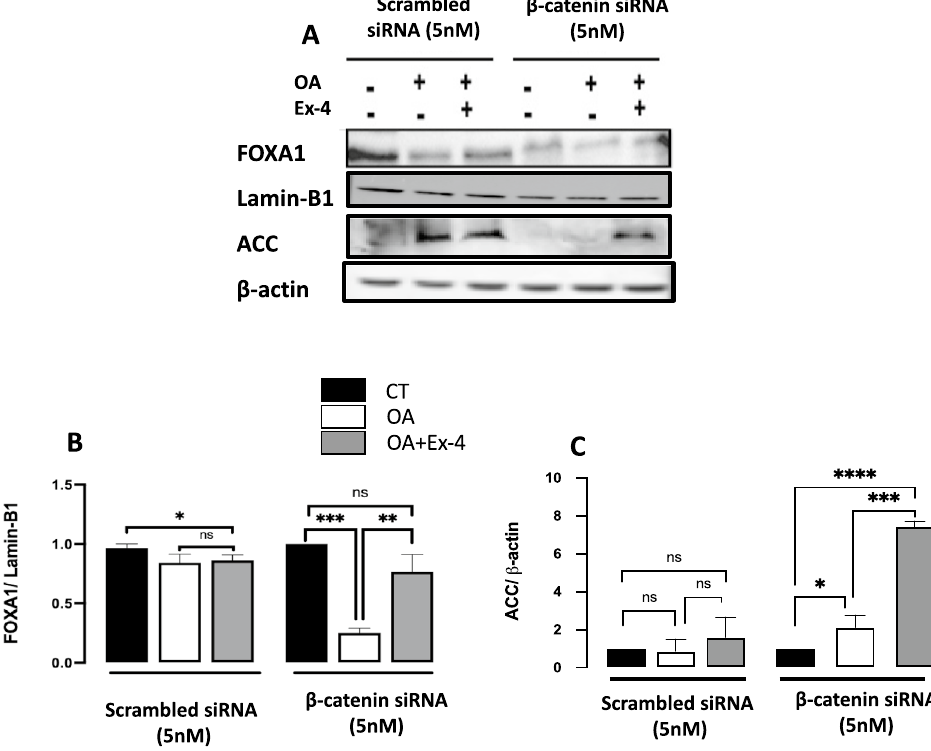
Figure 4. Effect of EX-4 on the protein expression of FOXA1 and ACC implicates β-catenin pathways. ( A ) Expression of FOXA1 and ACC was analyzed by western blotting in HepG2 cells transfected with 5 nM scrambled siRNA or β-catenin specific siRNA and then treated with 400 mM OA or 400 mM OA + 200 nM Ex-4 as indicated. ( B,C ) Quantification of the blots in ( A ). For ACC, beta-actin was employed as a loading control, while Lamin-B1 was used for FOXA1. All values are expressed as the mean ± SE (n = 3). * p < 0.05, ** p < 0.01, *** p < 0.001. Full-length blots are displayed in Supplementary